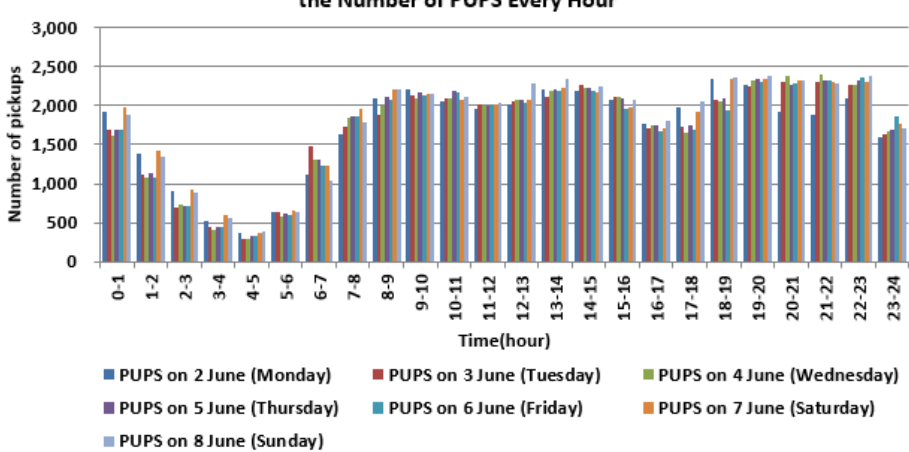
Figure 3. Number of PUPS (Pick-Up Points) every hour and the temporal variation during a week.